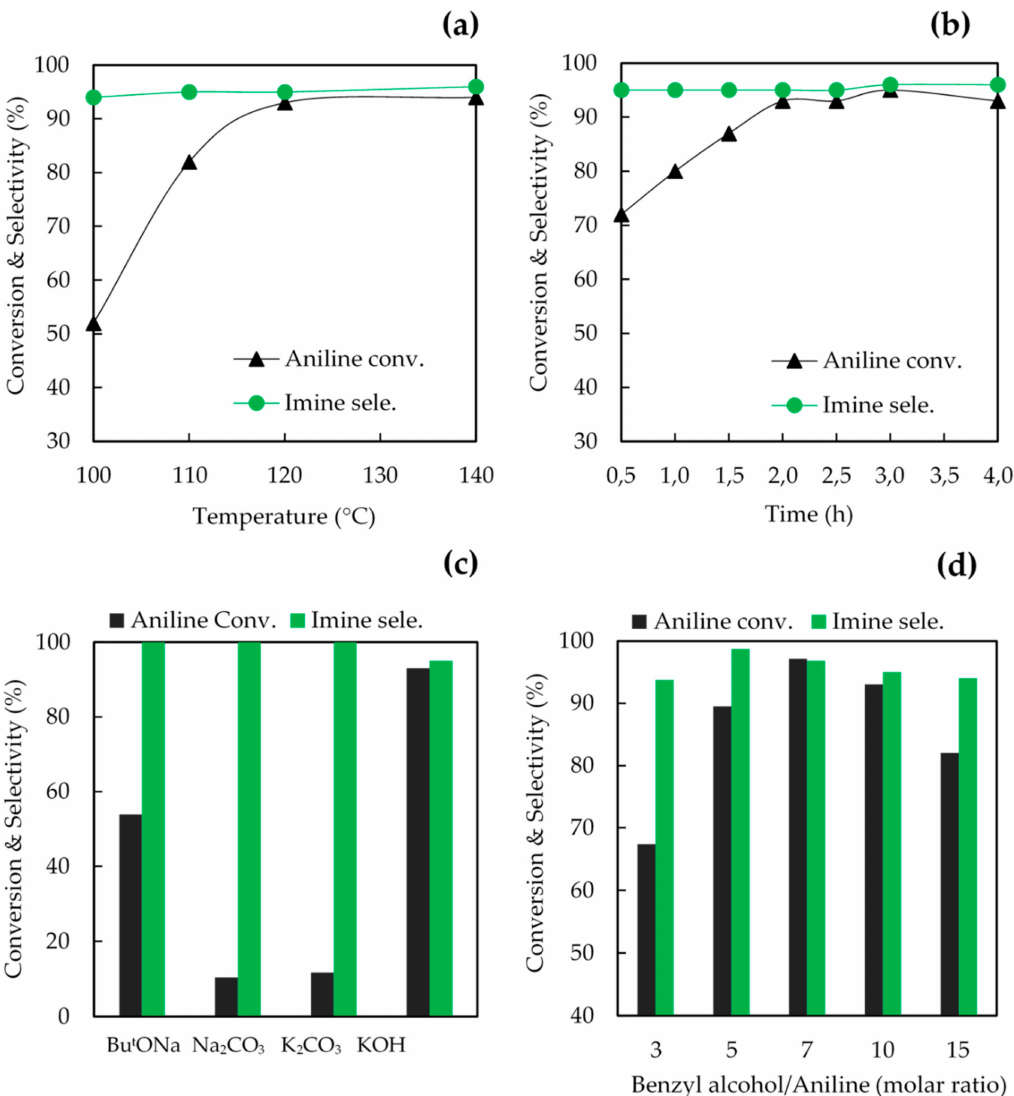
Figure 4. Catalytic activity over 53MOF / Al-SBA-15 catalyst, reaction conditions: 0.01 mol% catalyst (30 mg), 40.6 mmol xylene (5 mL) and ( a ) 1 mmol aniline (0.092 mL), 10 mmol benzyl alcohol (1.036 mL), 0.4 mmol KOH (20 mg) for 3 h, ( b ) 1 mmol aniline (0.092 mL), 10 mmol benzyl alcohol (1.036 mL), 0.4 mmol KOH (20 mg), at 120 ◦ C, ( c ) 1 mmol aniline (0.092 mL), 10 mmol benzyl alcohol (1.036 mL), at 120 ◦ C for 2 h and ( d ) 1 mmol aniline (0.092 mL), 0.4 mmol KOH (20 mg), at 120 ◦ C for 2